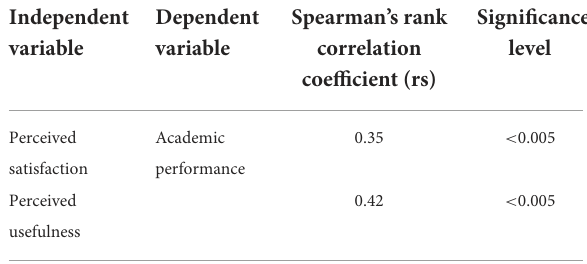
TABLE 2 Impact of students’ perceived satisfaction and perceived usefulness of mobile learning on academic